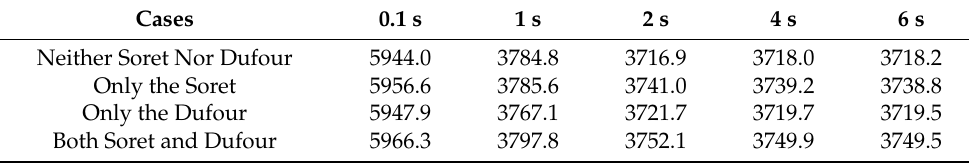
Table 3. The heat transfer coefficients for various cases and at various times (W/m 2 ·